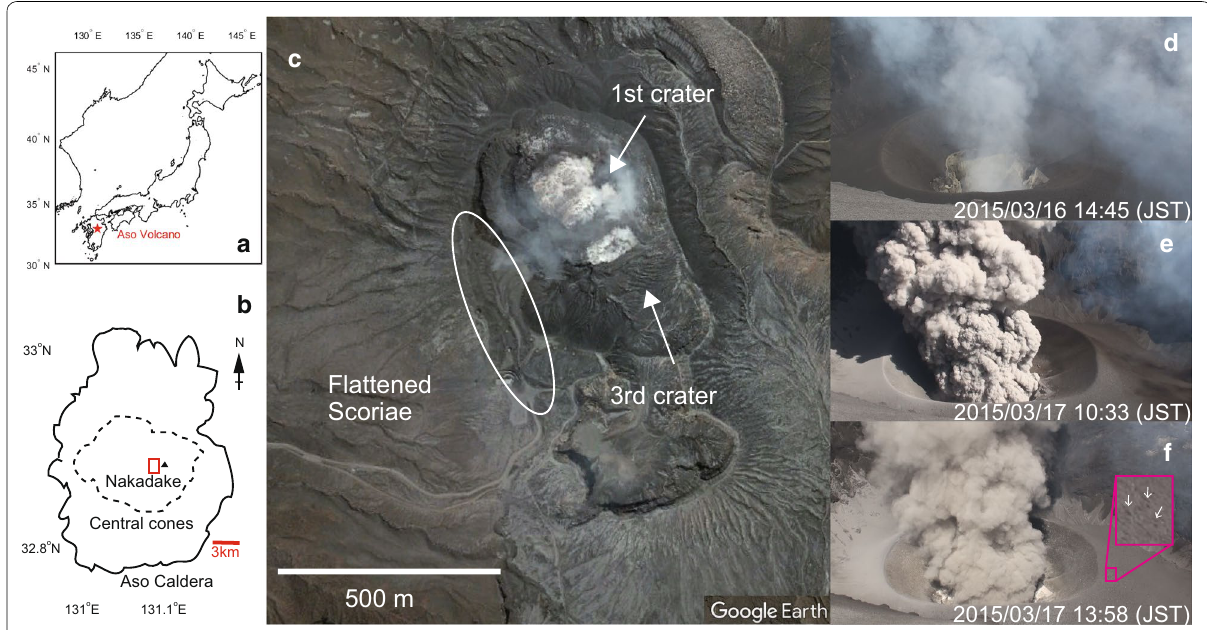
Fig. 1 Map of Aso Volcano. a Location of Aso Volcano. b Map of Aso Caldera and Nakadake. The red square shows the location of Fig. 1c. c Google Earth photograph of the Nakadake craters of Aso Volcano taken April 15, 2016. High-porosity samples are collected at the 3rd crater. Flattened samples are collected around the sites denoted by the white circle. d – f Photographs of plumes without ash emission, during vigorous ash emission, and at the end of ash emission, respectively. f The inset shows a magnification of the sediments. The black spots denoted by white arrows